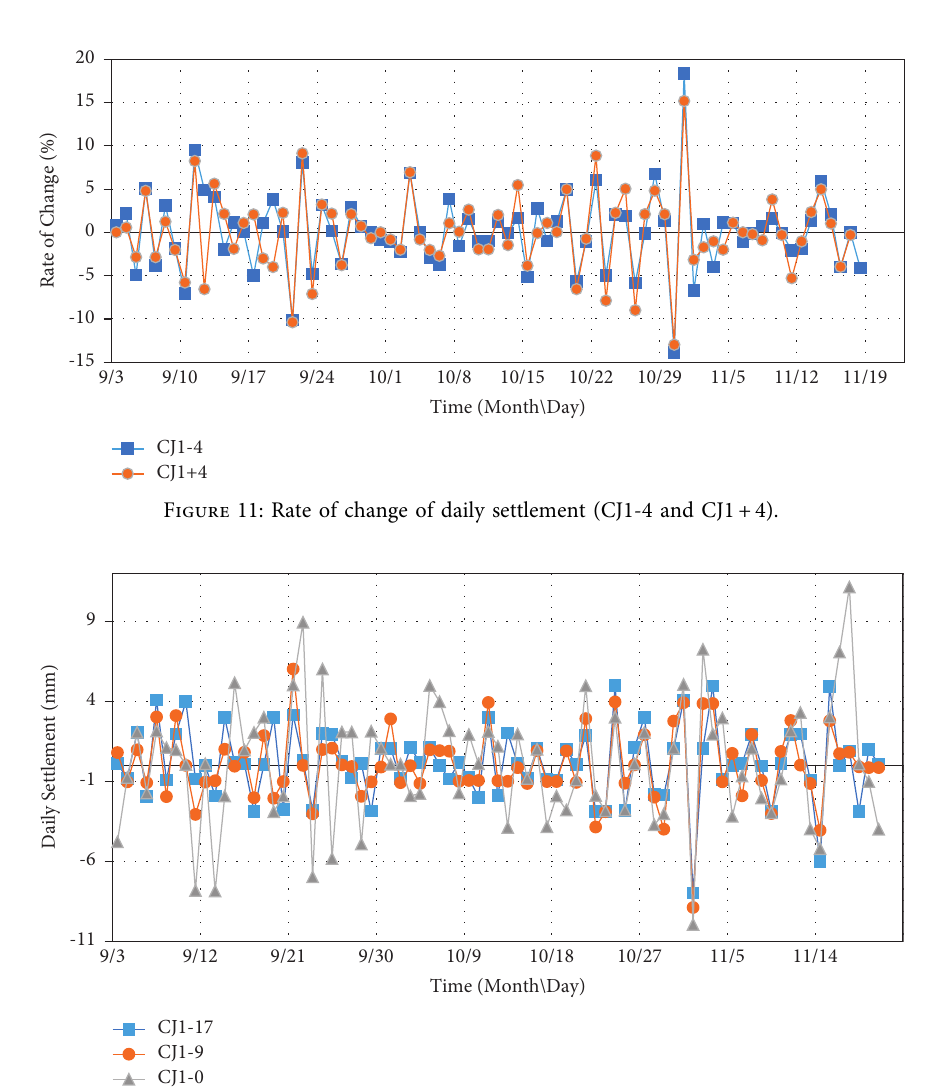
Figure 10: Daily settlement of CJ1-4 and CJ1 +4.